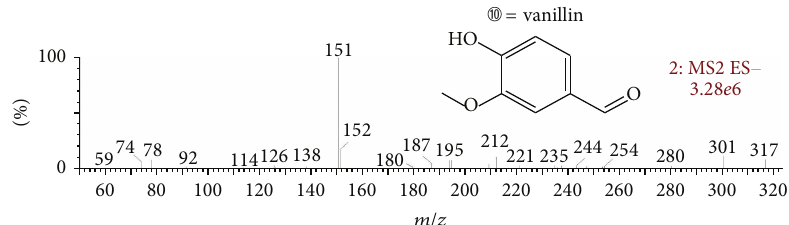
Figure 4: Representative MS spectra of A adenine, C gastrodin, D 5-hydroxymethylfurfural, E p-hydroxybenzylalcohol, F vanillyl alcohol, G p-hydroxybenzaldehyde, and 1 vanillin.